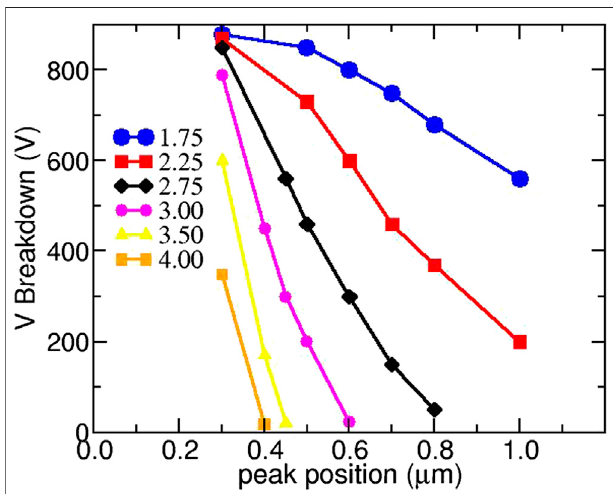
FIGURE 3 | Simulated breakdown voltage as a function of the peak position of the gain layer, for different implantation doses of the p -type gain layer (in units of 10 12 cm − 2 ). The simulation considers an example of 1- dimensional50 μ mthickLGADstructureanditisforexempli fi